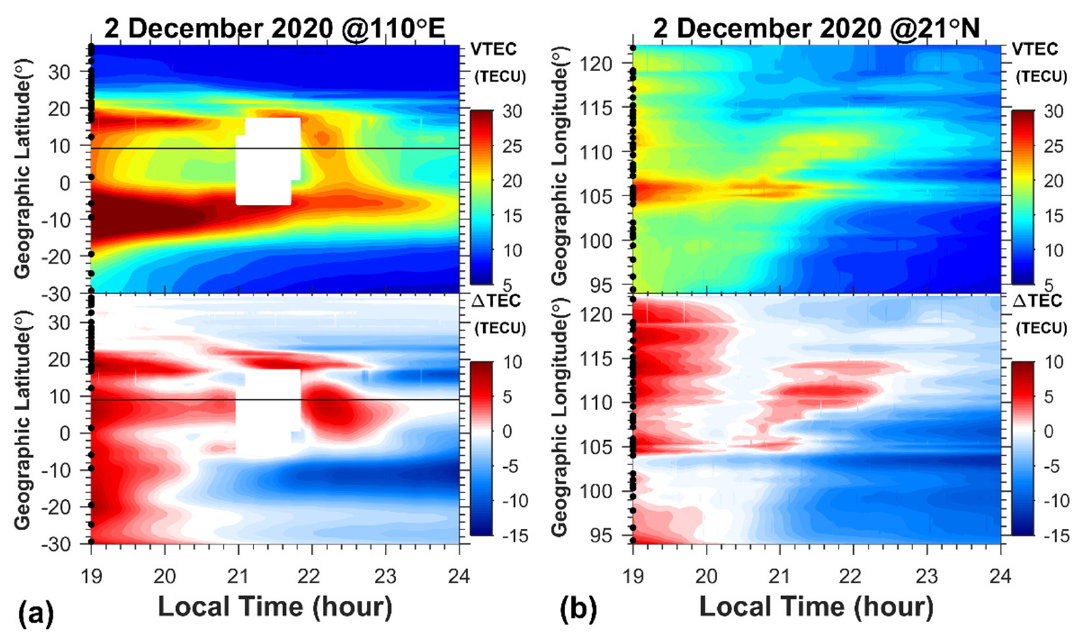
Figure 4. Contour maps of GEO TEC and Δ TEC at ( a ) 110° E and ( b ) 21° N during 19–24 LT on 2